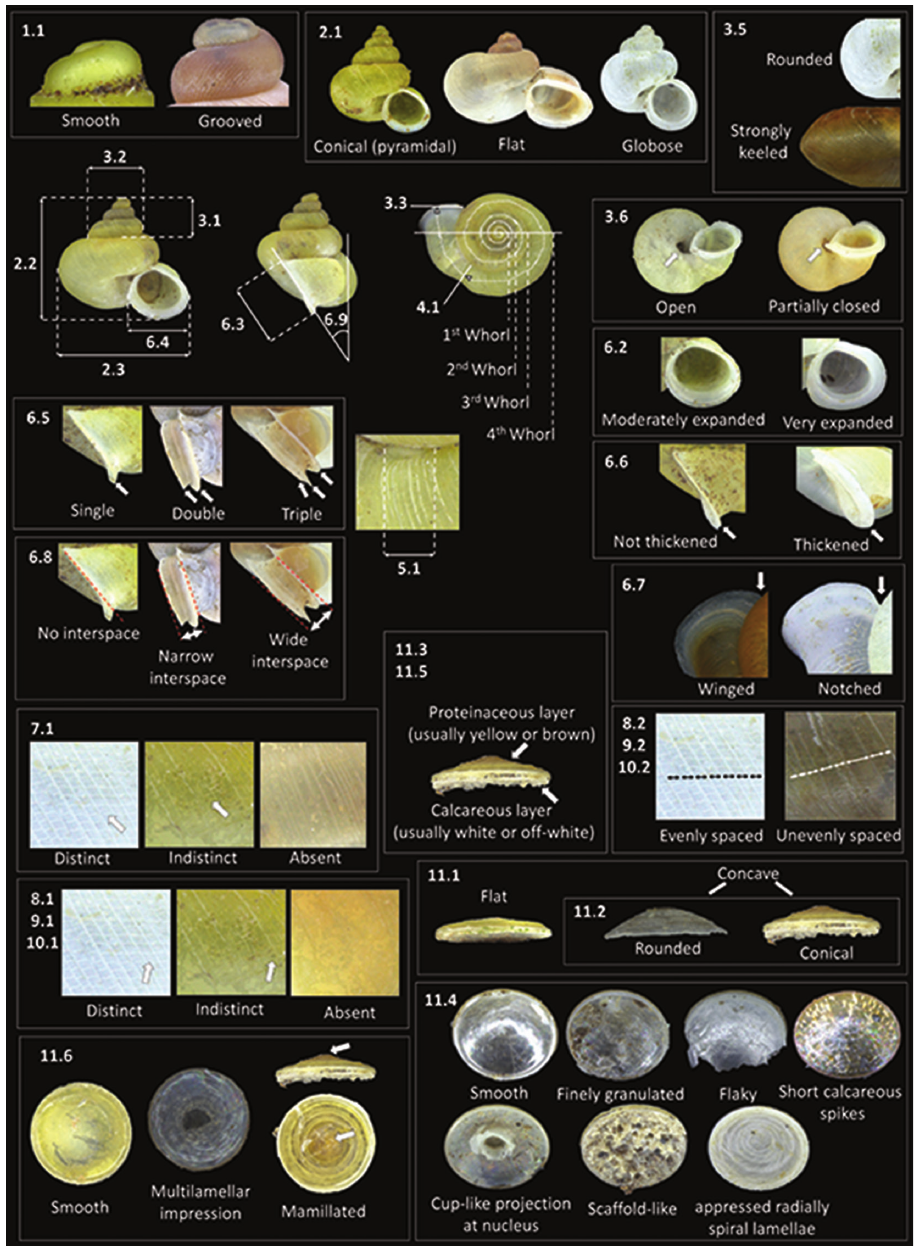
Figure 1. An illustrated synopsis of the framework for species description based on 39 shell and opercu- lum features (excluding shell colour and living animal colour). Number codes ascribed to each character are linked to descriptions and measurement methods outlined in Table